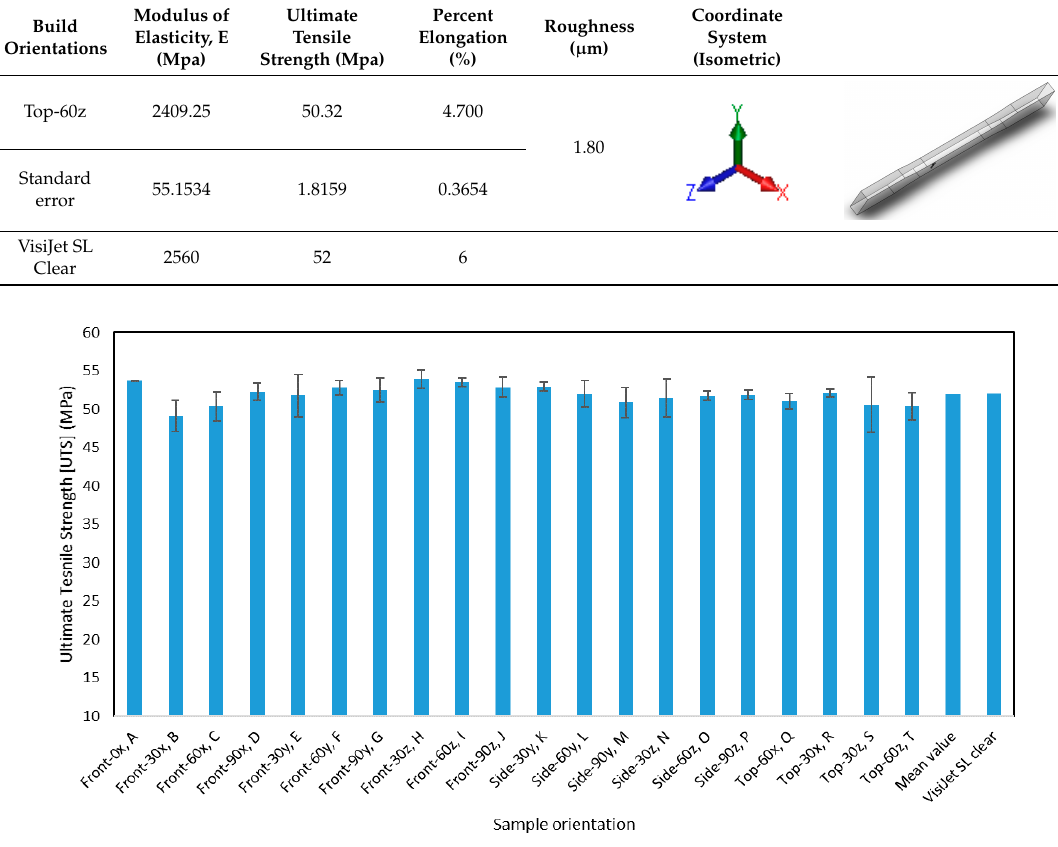
Figure 11. The ultimate tensile strength for the different orientations.